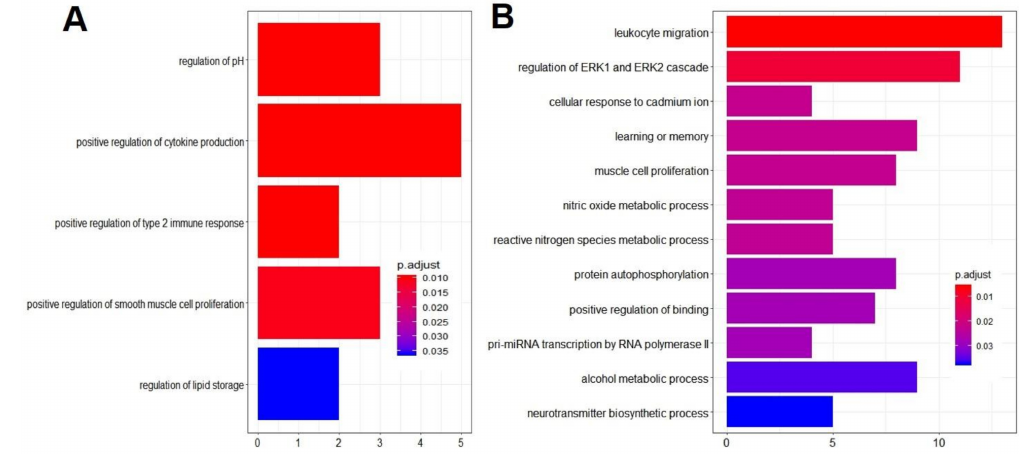
Figure 7. GO terms for biological processes overrepresented in EHM horses compared to non-EHM horses. ( A ) Upregulated biological processes and ( B ) downregulated biological processes. GO term enrichment analysis was performed using the enrichgo function of the clusterprofiler package in R. The resulting terms were filtered for redundancy using REVIGO. The nonredundant enriched GO terms are visualized here. The most significantly enriched terms are at the top and listed in decreasing significance (increasing p.adjust). The number of genes from our gene list are indicated on the x